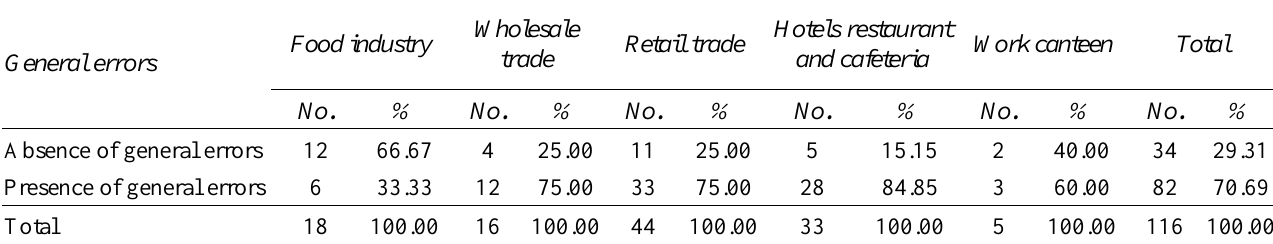
Table 3: Distribution of the general errors, for class of activity of the firms.